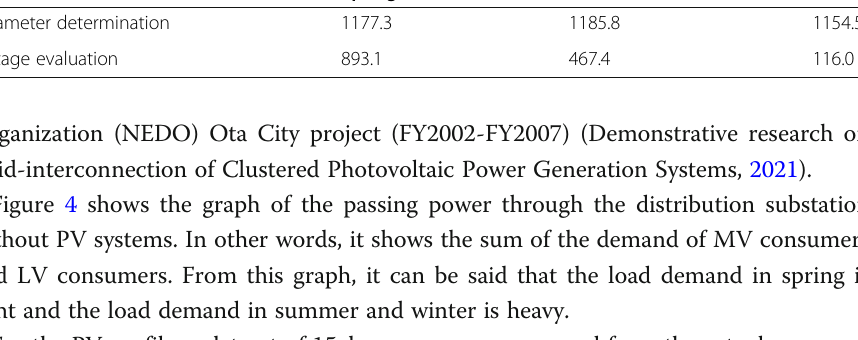
Table 2 the sum of PV generation amounts of each season (GW ∙ s)